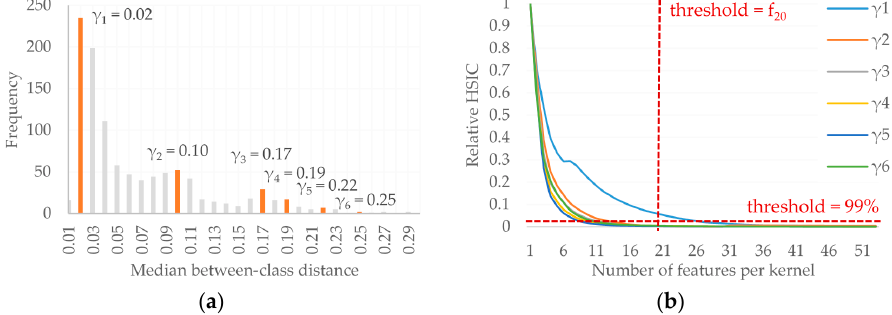
Figure 3. The proposed feature selection method, first using peaks in the between-class distance histogram to identify candidate bandwidth parameters ( a ); and then using the feature ranking to determine which features to include in each group ( b ). The dashed red lines indicate the cut-off thresholds according to either a maximal number of features per kernel (f 20 ) or relative HSIC value (99%). Note that the graphs represented here do not reflect the exact data from the experiments, but have been slightly altered for illustrative purposes.